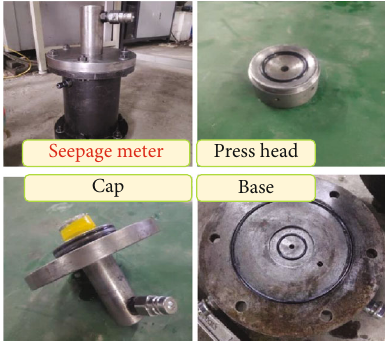
Figure 6: Photos of the seepage meter and its